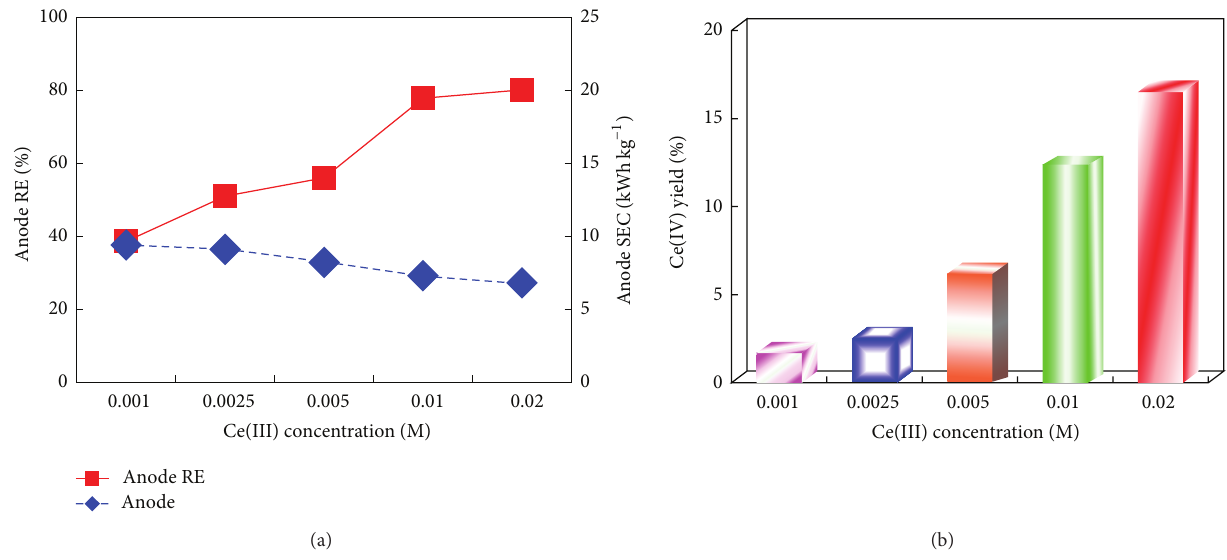
Figure 3: Effect of initial Ce(III) concentration: (a) removal efficiency and SEC of PVA and (b) Ce(IV) yield with different initial Ce(III) concentration in the anodic compartment (current density = 3 mAcm −2 , temperature = 323 K, anodic compartment: PVA = 50 mgL −1 , HNO 3 = 0.2 M; cathodic compartment: PVA = 50 mg L −1 , Na 2 SO 4 = 0.05 M, pH = 3, oxygen flow rate = 500 cm 3 min −1 , and UV-light intensity = 0.4 mWcm −2